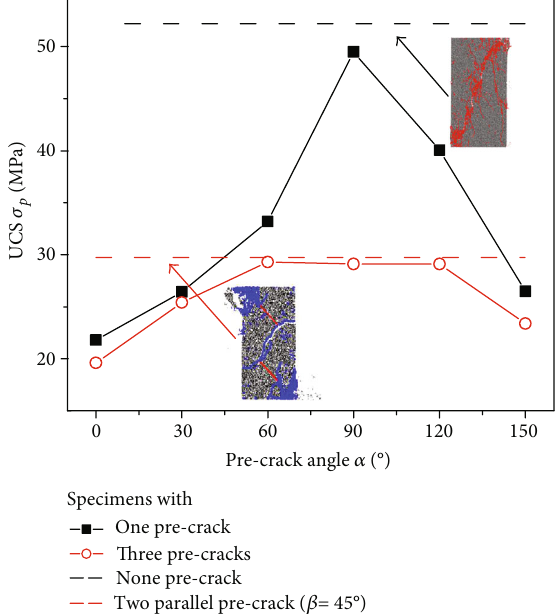
Figure 9: Correspondence between UCS of specimens and precrack angles.